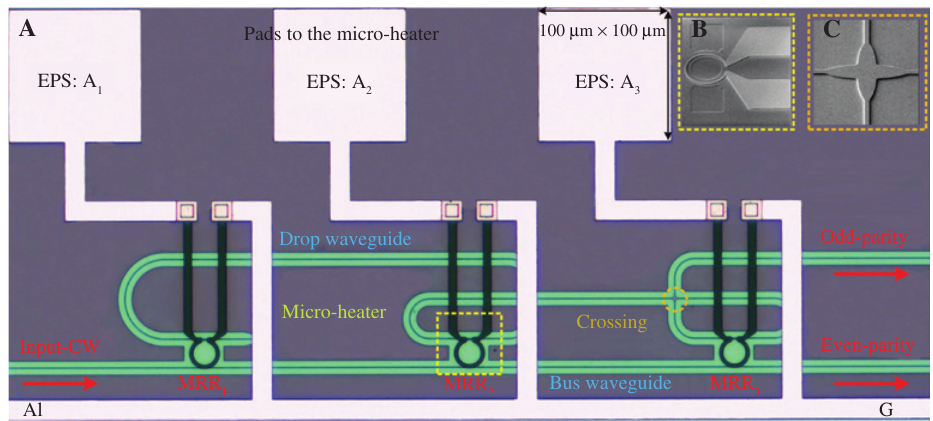
Figure 3: The proposed device is fabricated based on the CMOS process. (A) Micrograph of the fabricated 3-bit optical parity checker. (B) and (C) Scanning electronic micrograph (SEM) of Ω -shaped TiN micro-heater and elliptical structure, respectively.